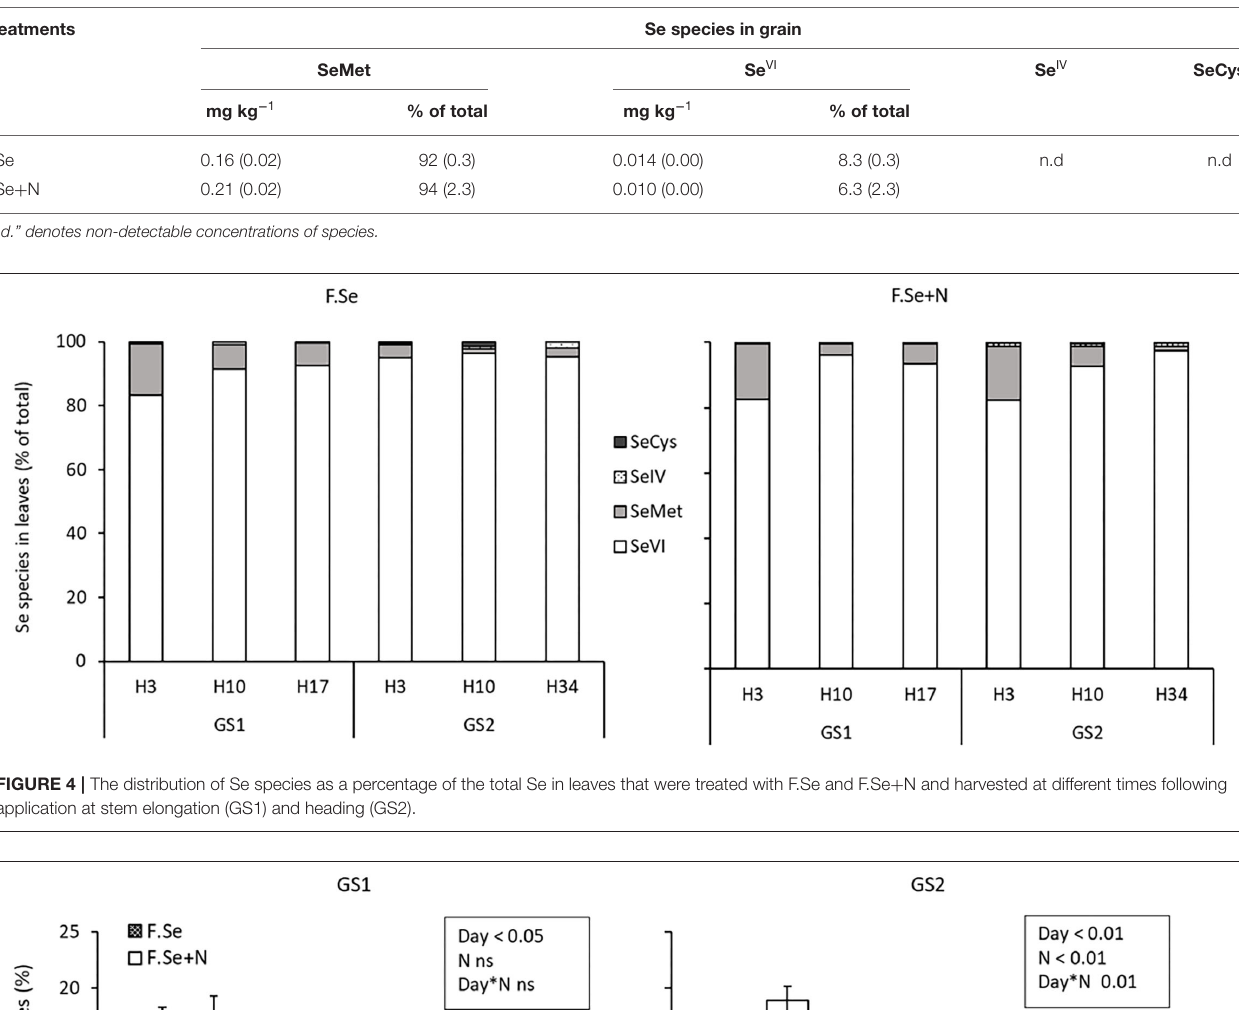
of the plant compared with other Se species ( Figure 4 ). The influence of N on the SeMet concentration in leaves and its translocation was observed only at GS2 ( Figure 5 ). The application of F.Se + N led to significantly more transformation of the applied inorganic Se into SeMet, resulting in more rapid translocation of SeMet away from the application leaf ( Figure 5 ).